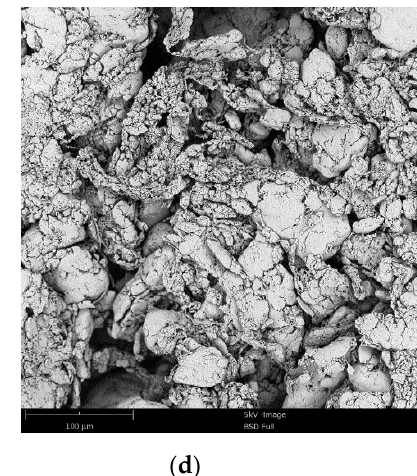
Figure 1. The scanning electron microscope (SEM) images of the raw materials: ( a ) Hf powder; ( b ) THV 220 granules; ( c ) Al powder; ( d ) PTFE powder. Table 1. The specimen formulas and theoretical energy content.